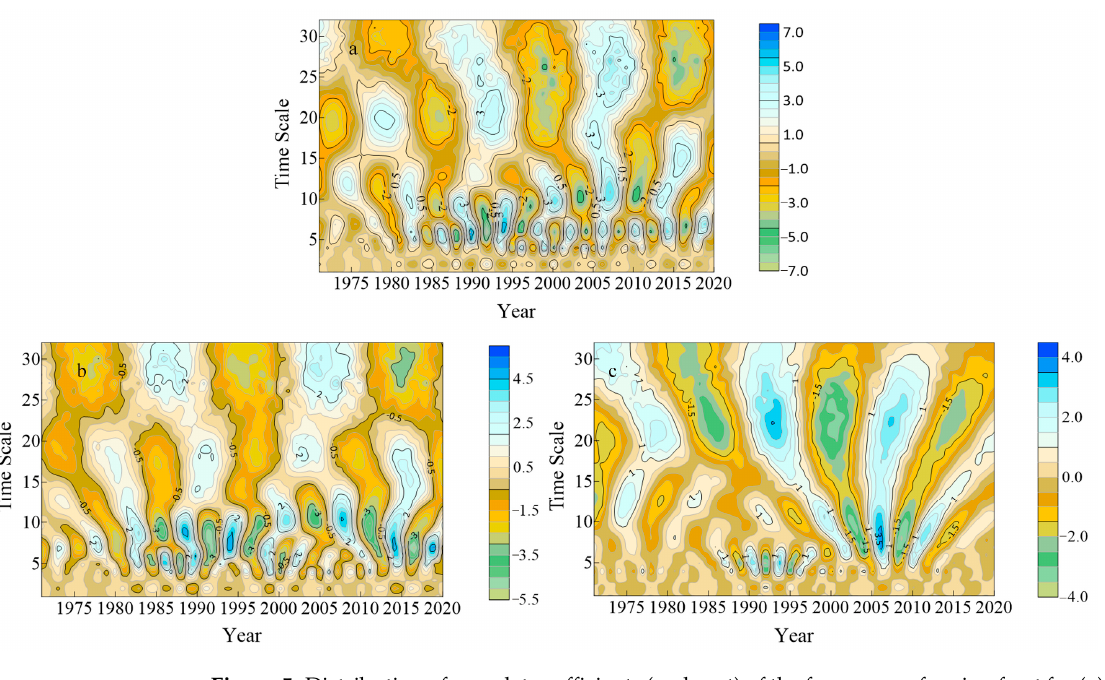
Figure 5. Distribution of wavelet coefficients (real part) of the frequency of spring frost for ( a ) Xinjiang, ( b ) Northern Xinjiang, and ( c ) Southern Xinjiang.